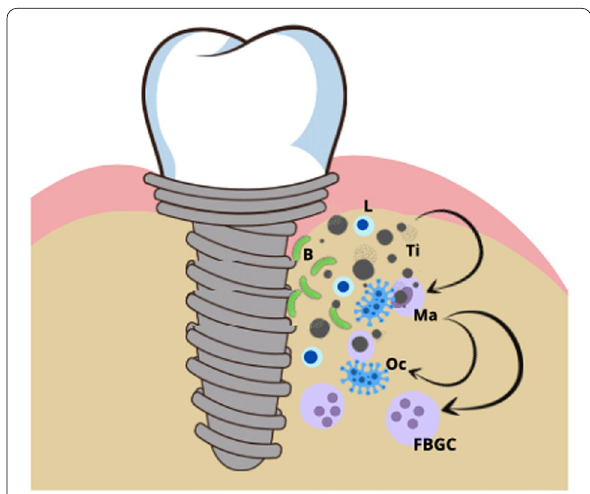
Fig. 1 Disruption of the immunological equilibrium and hypothesized immunological cascade of titanium hypersensitivity. Titanium particles trigger a cascade of inflammatory reactions. Macrophages are activated and recruited. Lymphocytes enhance macrophage adhesion and fusion on material surfaces. Macrophages activate osteoclasts and fuse into FBGC leading to bone resorption and secondary bacterial invasion. L lymphocyte, B bacteria, Ma macrophage, Oc osteoclasts, FBGC Foreign Body Giant